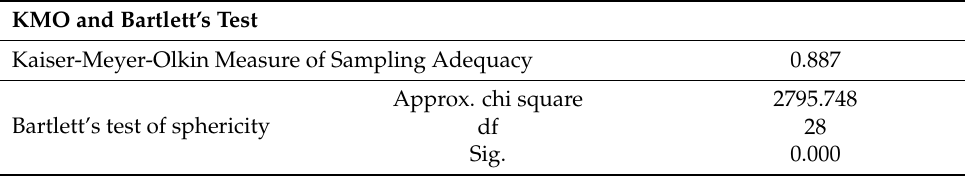
Table 7. Kaiser–Mayer–Olkin test of sampling adequacy and Bartlett’s test of